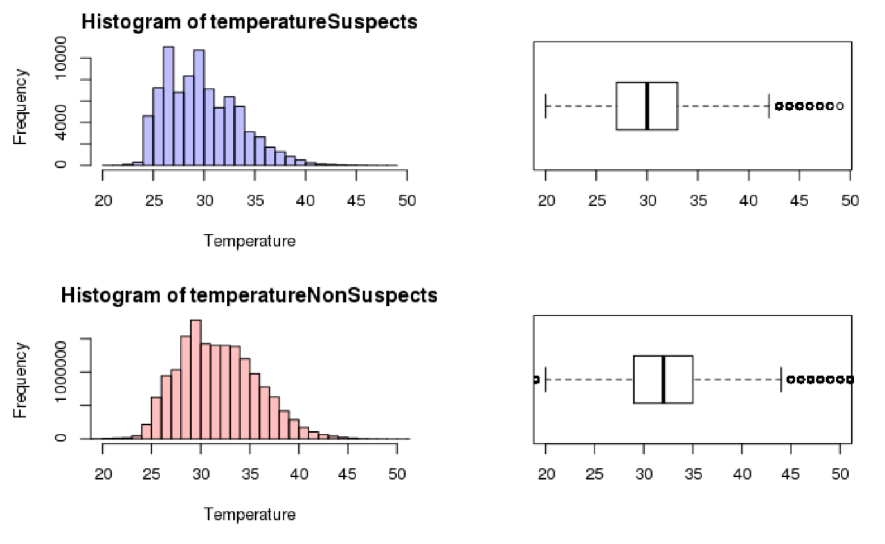
Figure 3. Correlation with device